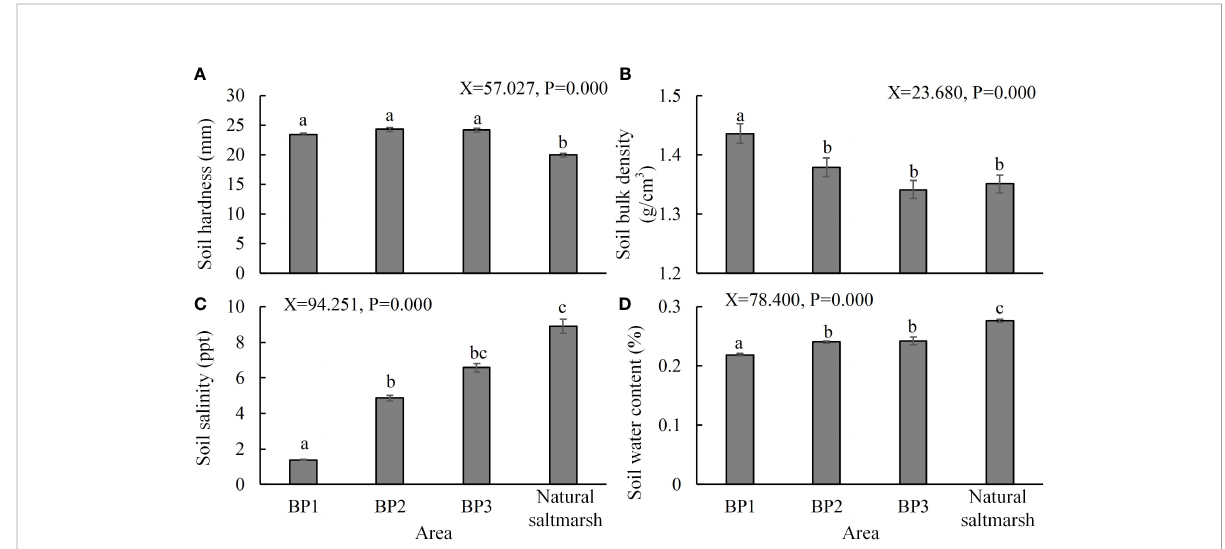
FIGURE 6 (A) Soil hardness, (B) bulk density, (C) salinity, and (D) water content of the three types of bare patch and natural saltmarsh. BP1, BP2, and BP3 represent complete-enclosed, semi-enclosed and open bare patches, respectively (N = 120). Data are means ± SE. Signi fi cant differences are shown by different letters above the